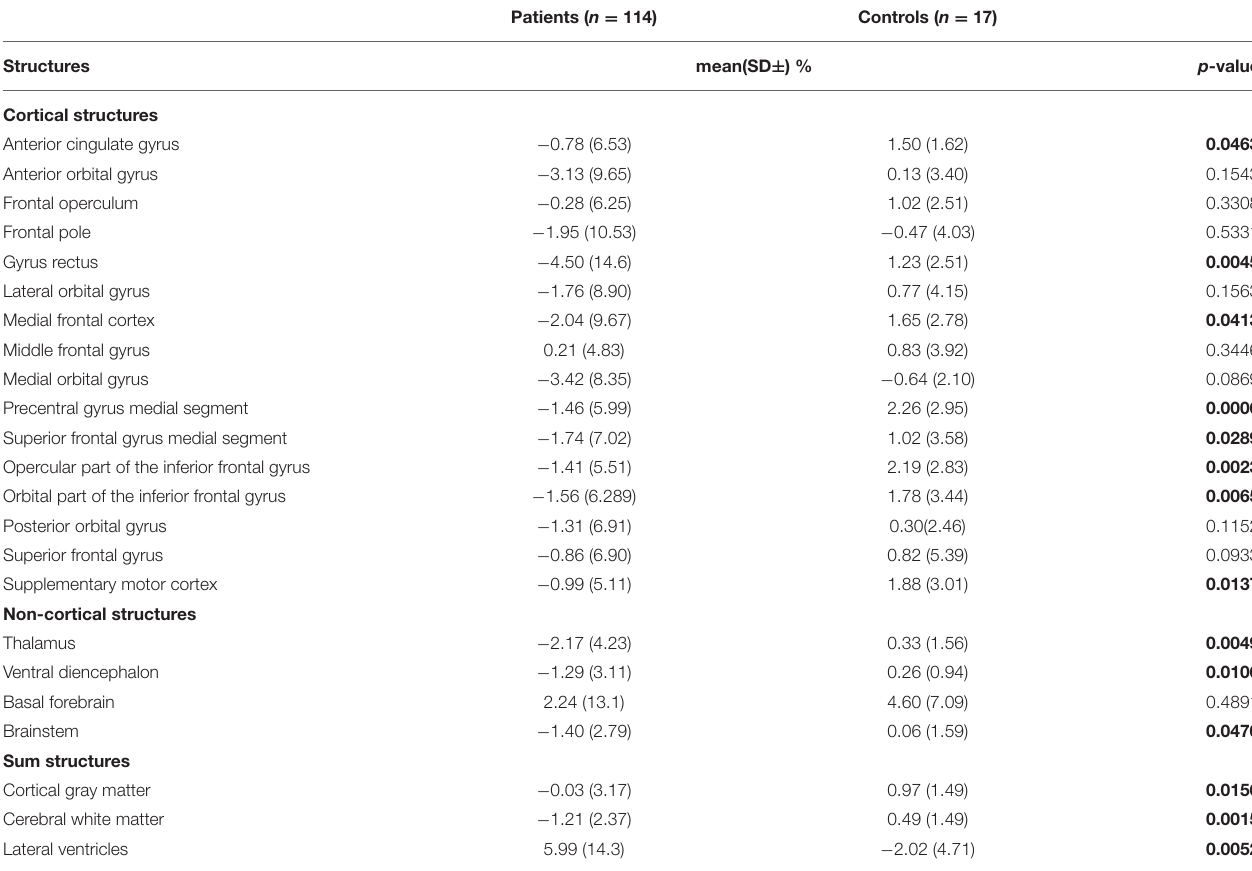
TABLE 3 | Atrophy rate differences between TBI subjects and